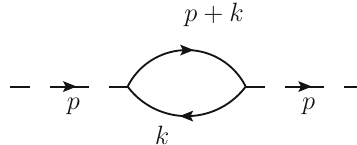
Fig. 4 Self-energy loop graph in the scalar